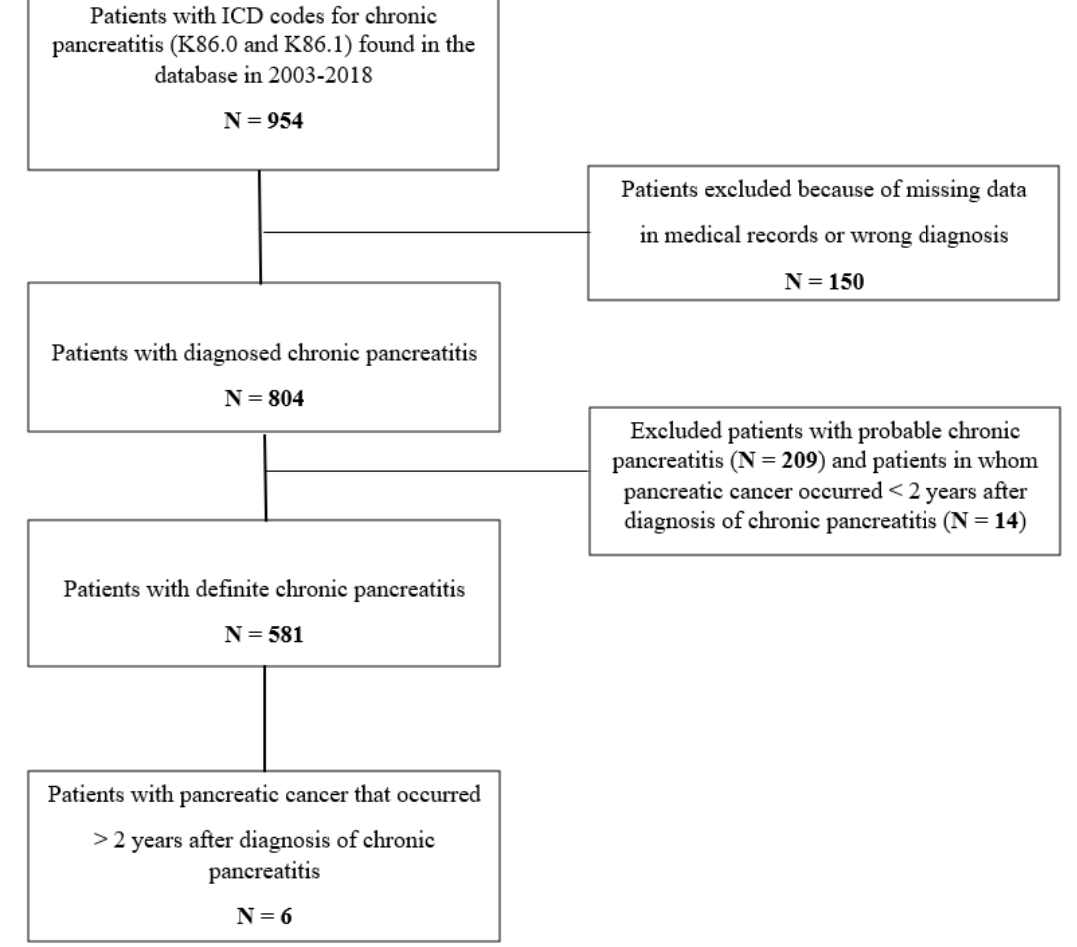
Figure 1. Flow chart of patients.